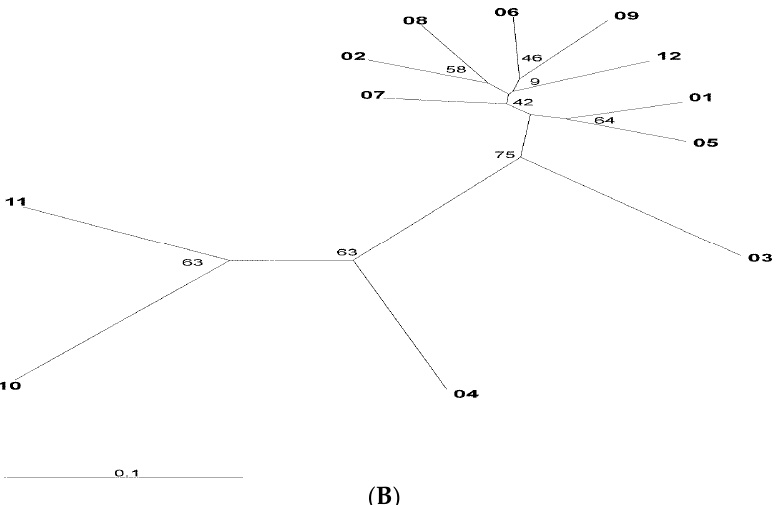
Figure 2. Relationships between 12 Romanov sheep populations from different regions of the Russian Federation. ( A ): geographical map. The arrows indicate possible directions of animal export. ( B ): phylogenetic relationship based on the cluster analysis. Bootstrap values are indicated at each node.